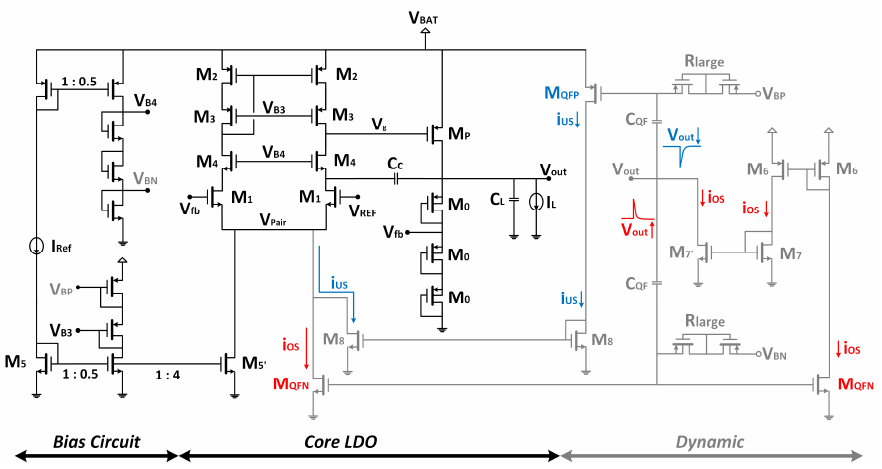
Figure 3. Schematic of the proposed CMOS LDO regulator.